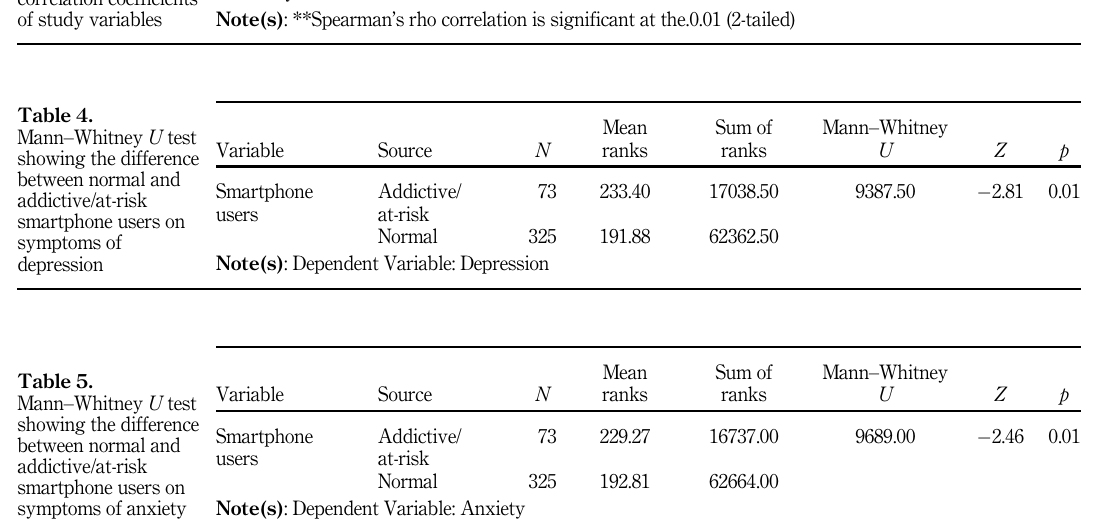
Table 3. Spearman ’ s rho correlation coefficients of study